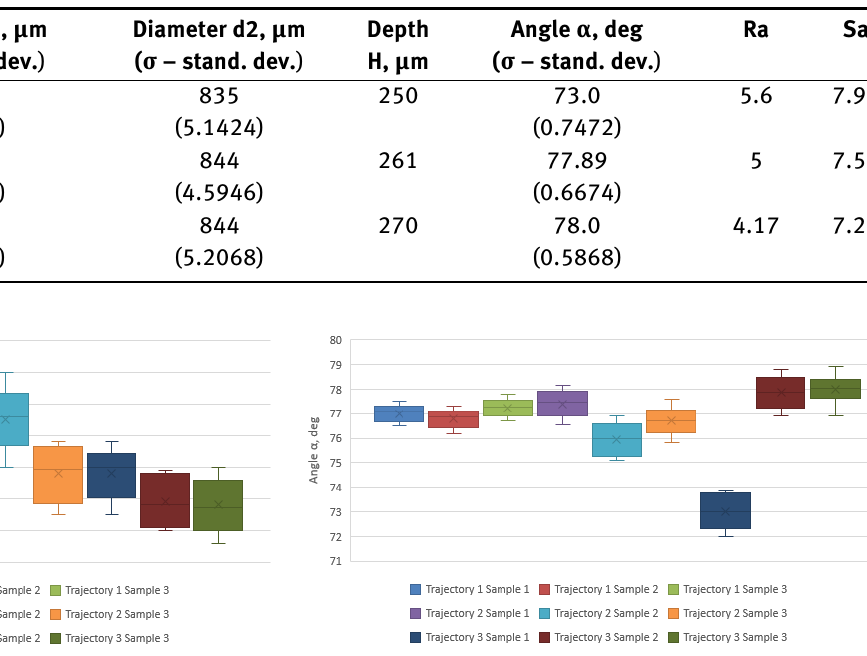
Table 3: List of measurement results for trajectory 3.